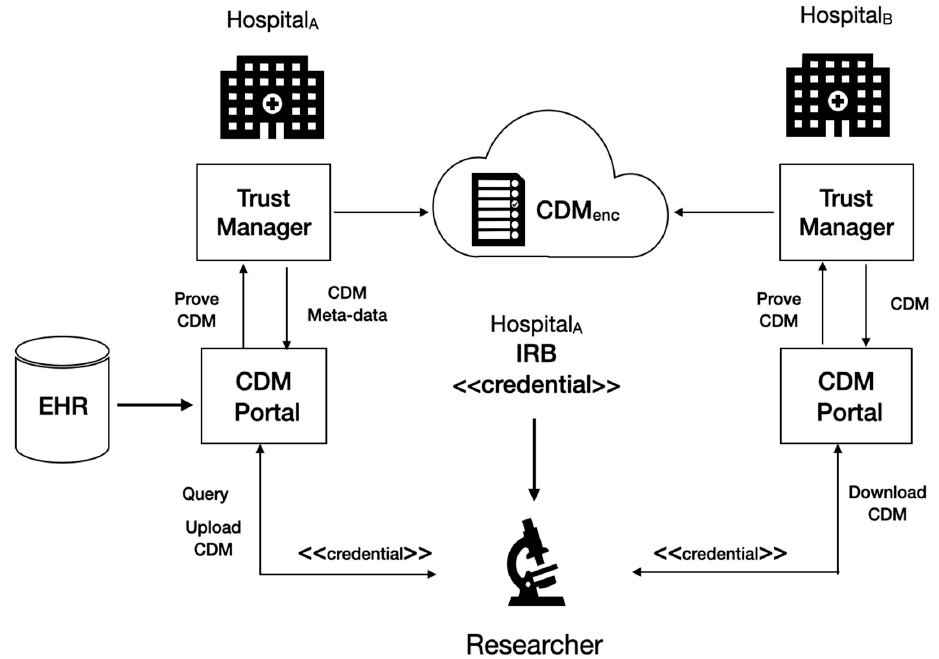
Figure 4. The overall concept of authentication and authorization in cloud CDM.